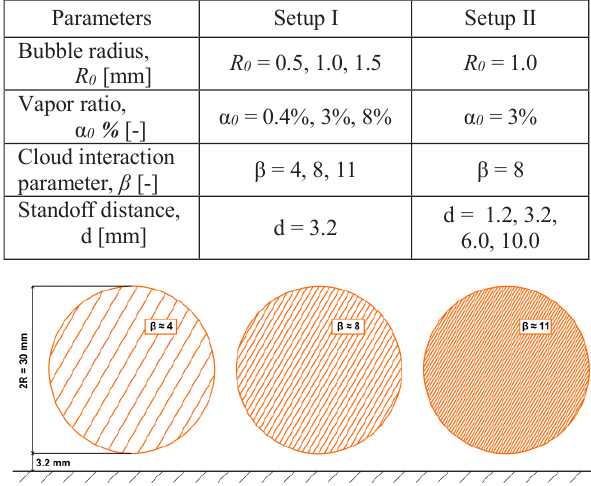
Fig. 3a: Schematic visualization of Setup I: different β